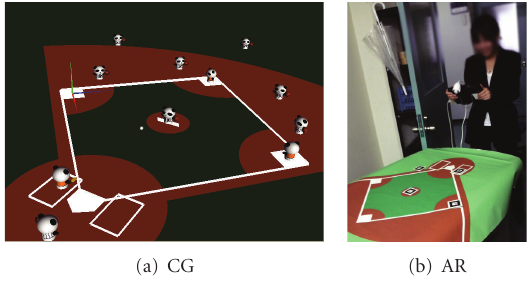
Figure 20: Prepared baseball